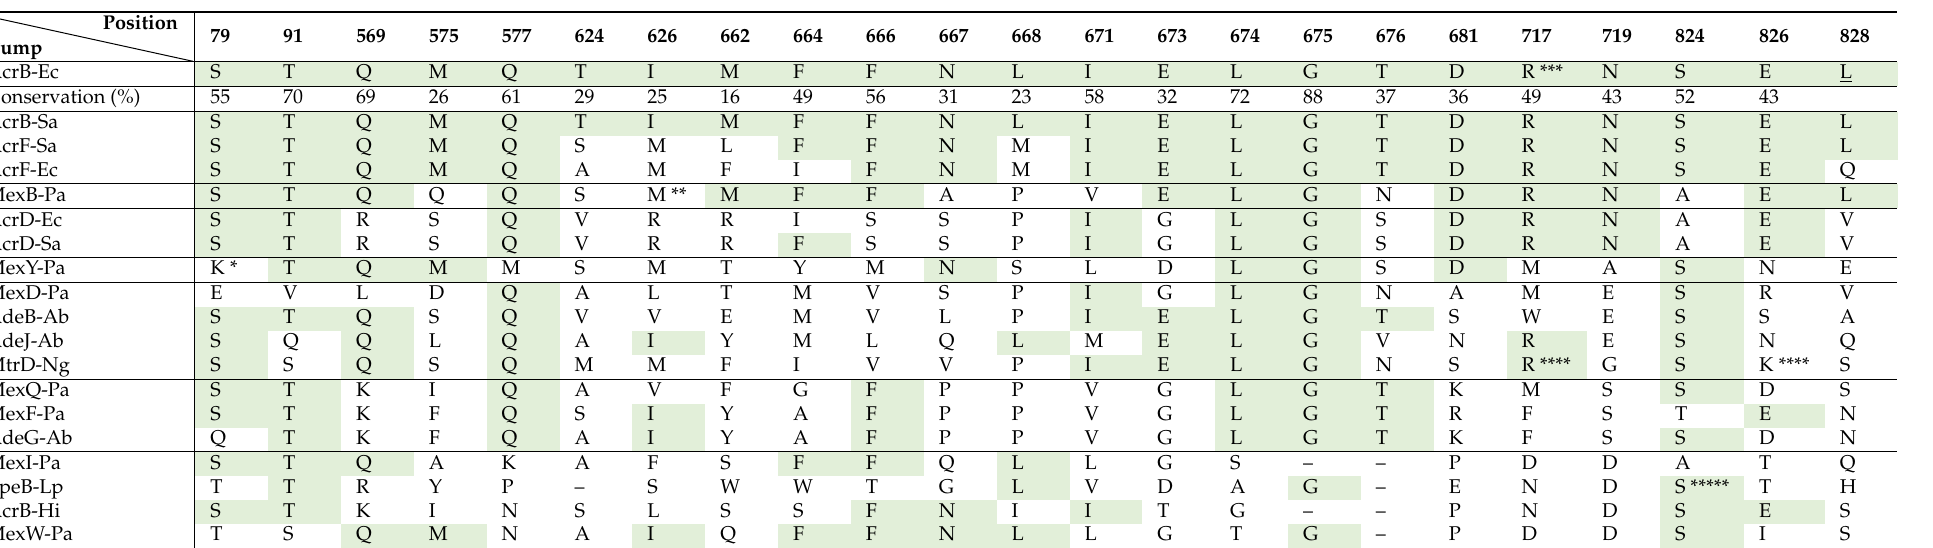
Table 6. Overview of residues in the PBP area of 19 selected RND-type MDR transporters, and conservation among 135